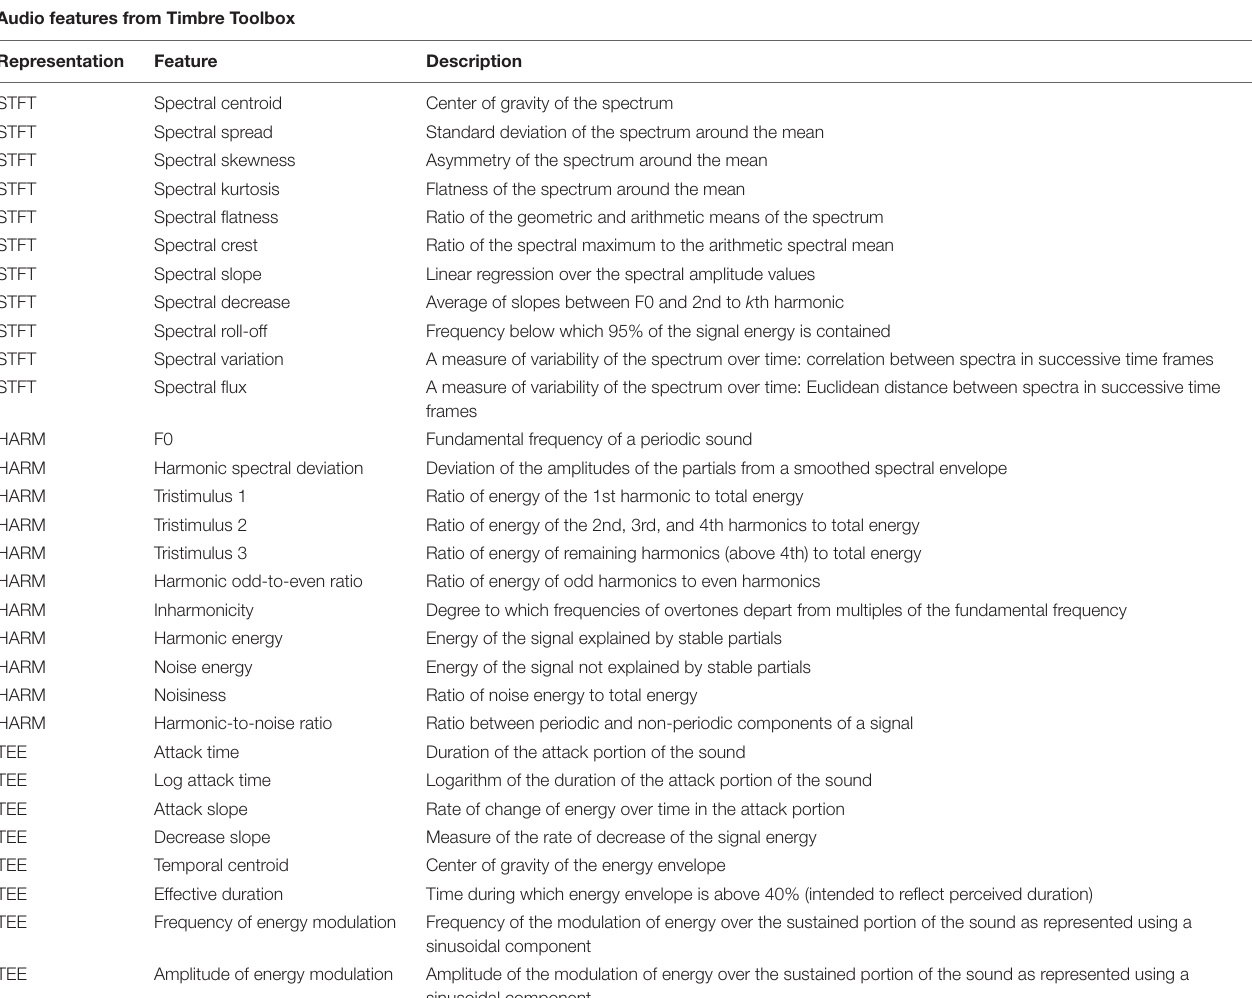
TABLE 3 | Audio features extracted from Timbre